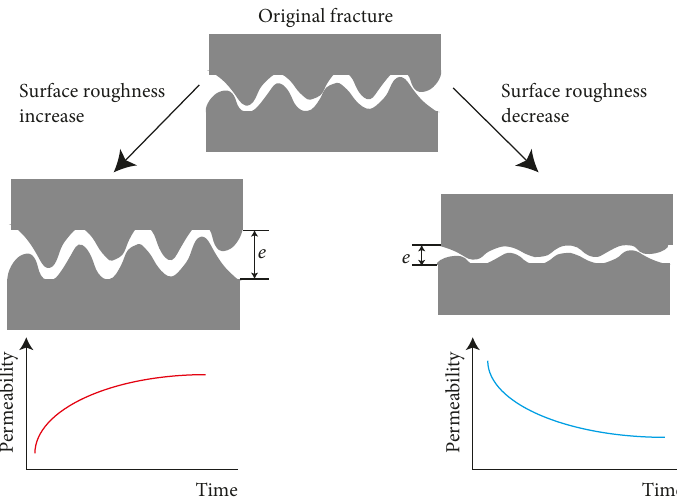
Figure 8: Schematic map of relationship between fracture roughness and permeability evolution.